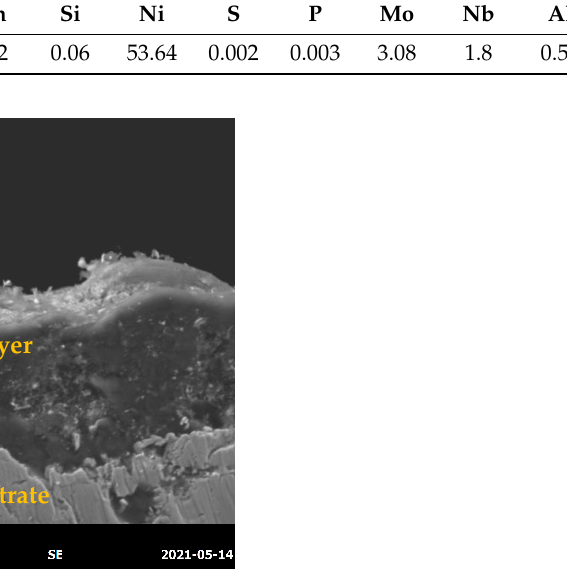
Table 2. Chemical composition of KHR 45A steel in wt.%.